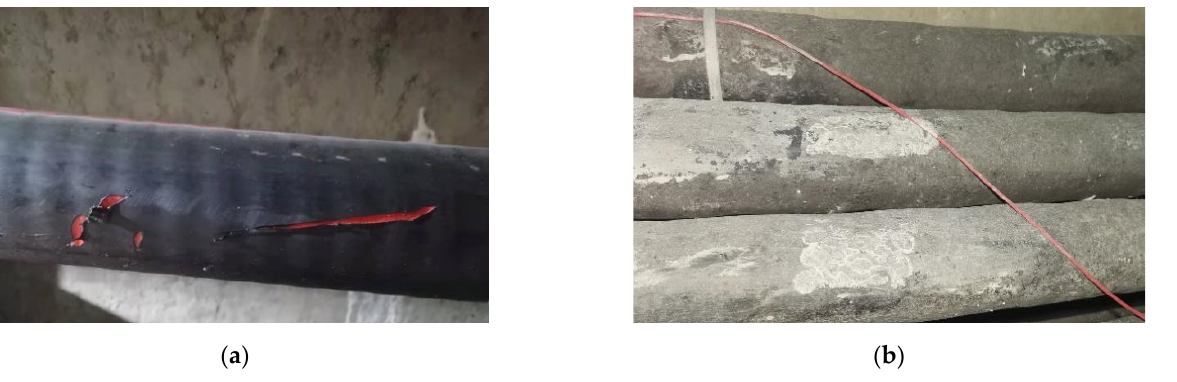
Figure 10. survey photos: ( a ) The mechanical damage type.; ( b ) The natural aging type.